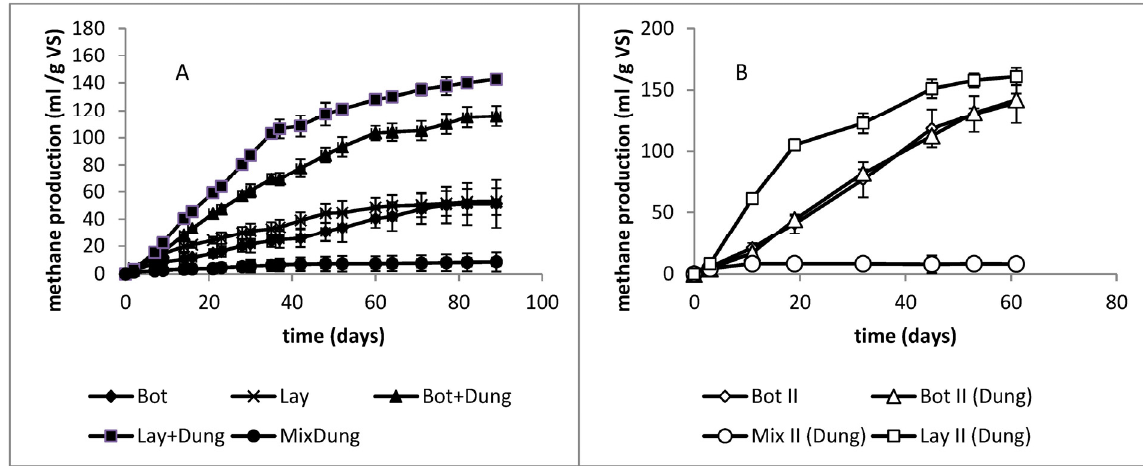
Figure 2. Accumulative methane yields from SSAD of yam peelings in the first run ( A ) and second run ( B